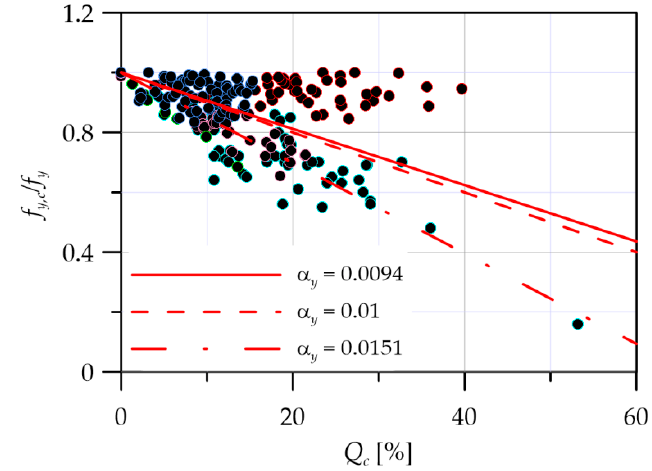
Figure 2. Experimental yield capacity ratio versus average corrosion degree of corroded steel rebar.